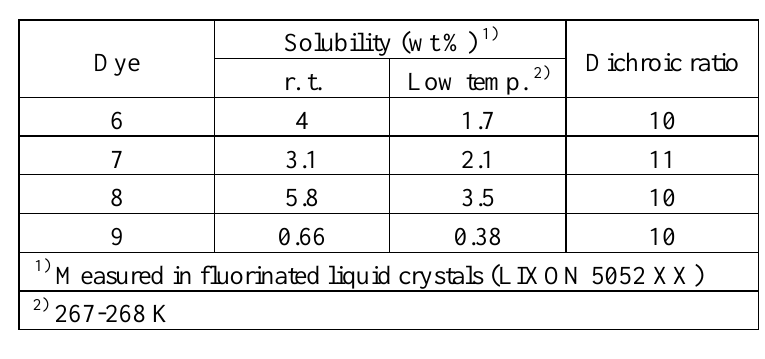
Table 2. The relationships between molecular structures of yellow anthraquinone dyes and their solubilities and dichroic